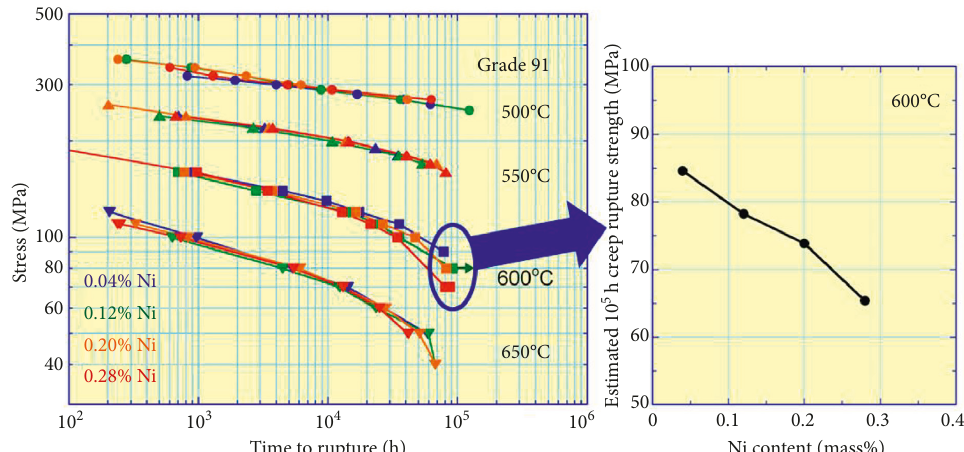
Figure 10: The influence of Ni on the creep strength in Grade 91 steel as reported by [37]. The detail at right shows that the 100,000 creep rupture strength decreases with increasing Ni content.